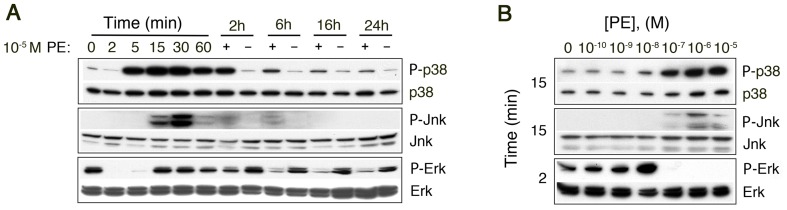
Western analysis of high dose α1aAR induced MAPK activation using phospho-specific antibodies for activated kinases.α1aAR expressing cells were placed into SF media for 3–4 hours, treated with PE for the indicated time and collected by direct addition of SDS sample buffer. (A) Time course following treatment with 10−5 M PE shows strong p38 activation, transient Jnk activation and acute inhibition of already low basal ERK activity followed by transient partial recovery. (B) Dose response of PE and MAPK phosphorylation. Following transfer to serum free media the cells were treated for 15 or 2 min with 0 to 10−5 M PE as indicated.